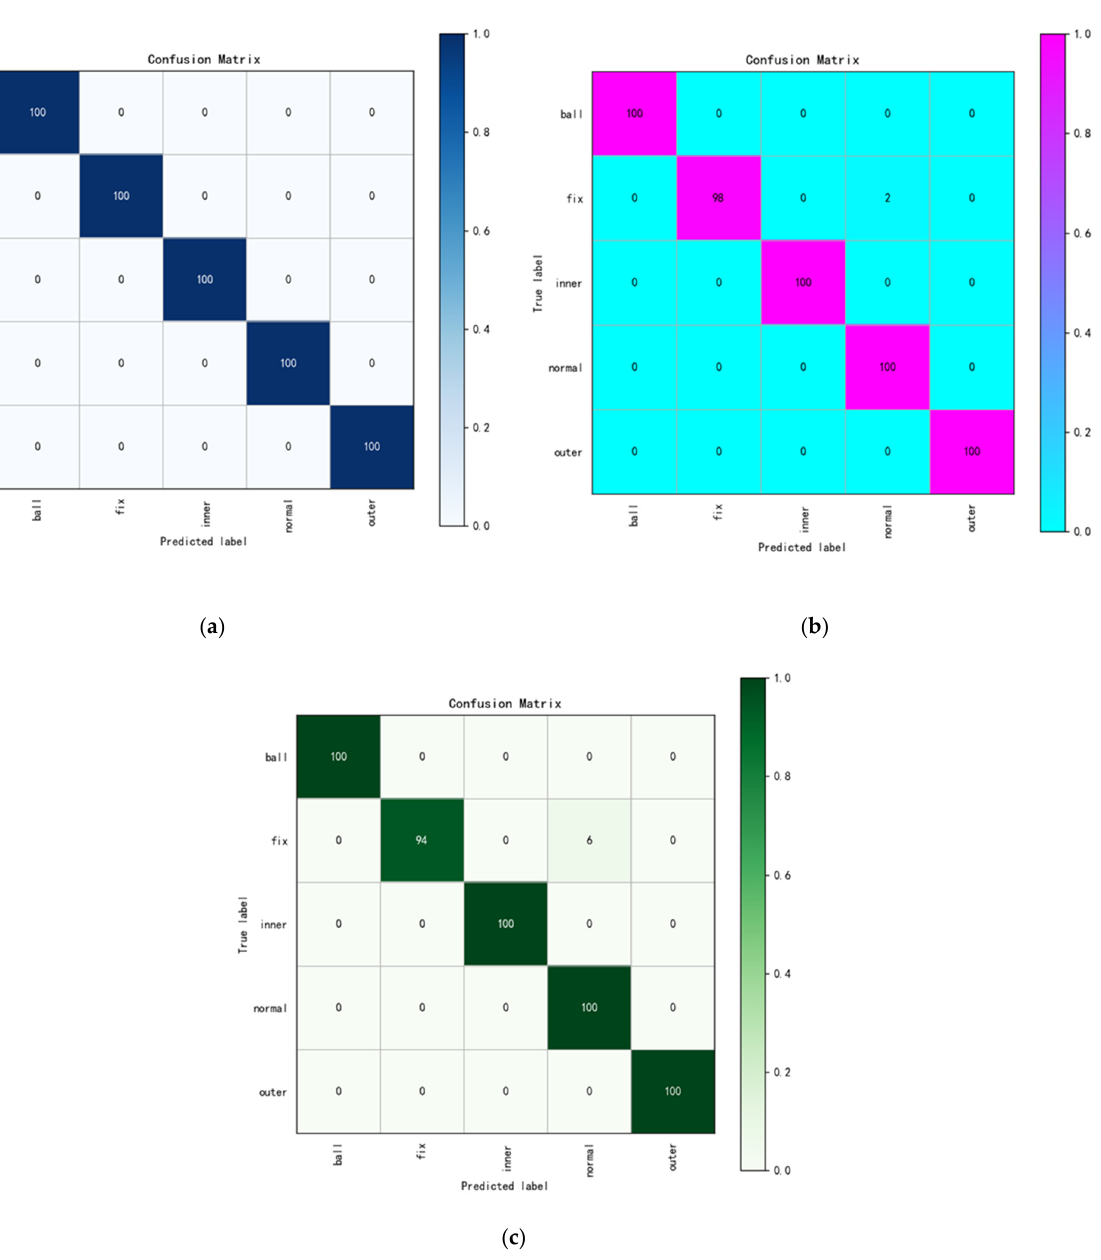
Figure 11. The confusion matrix of different datasets: ( a ) the result of Dataset A; ( b ) the result of Dataset B; ( c ) the result of Dataset C.